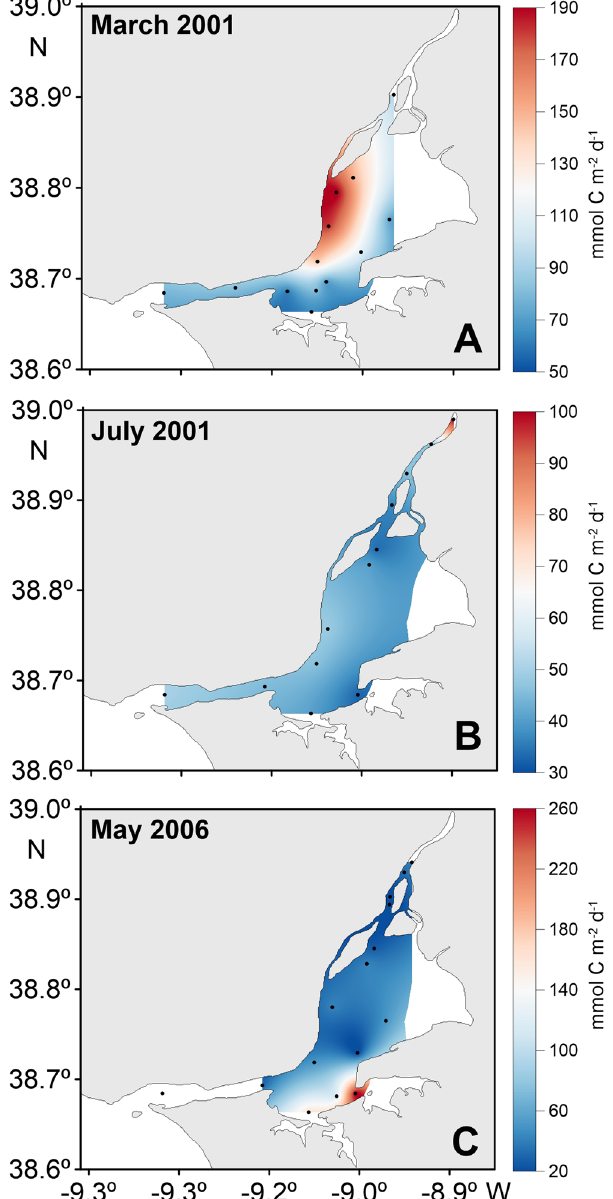
Figure 6. Water-air CO 2 fluxes (mmol C m − 2 d − 1 ) distribution along Tagus estuary in ( A ) March 2001, ( B ) July 2001 and ( C ) May 2006. Figure generated using the software Surfer Version 12.8.1009 (http://www. goldensoftware.com/products/surfer), a surface mapping system from Golden Software, LLC. Coastline and bathymetry were created based on Google “Map data: Google, Earth” (https://www.google.pt/maps/) and on data SIO, NOAA, U.S. Navy, NGA, GEBCO version 20141103